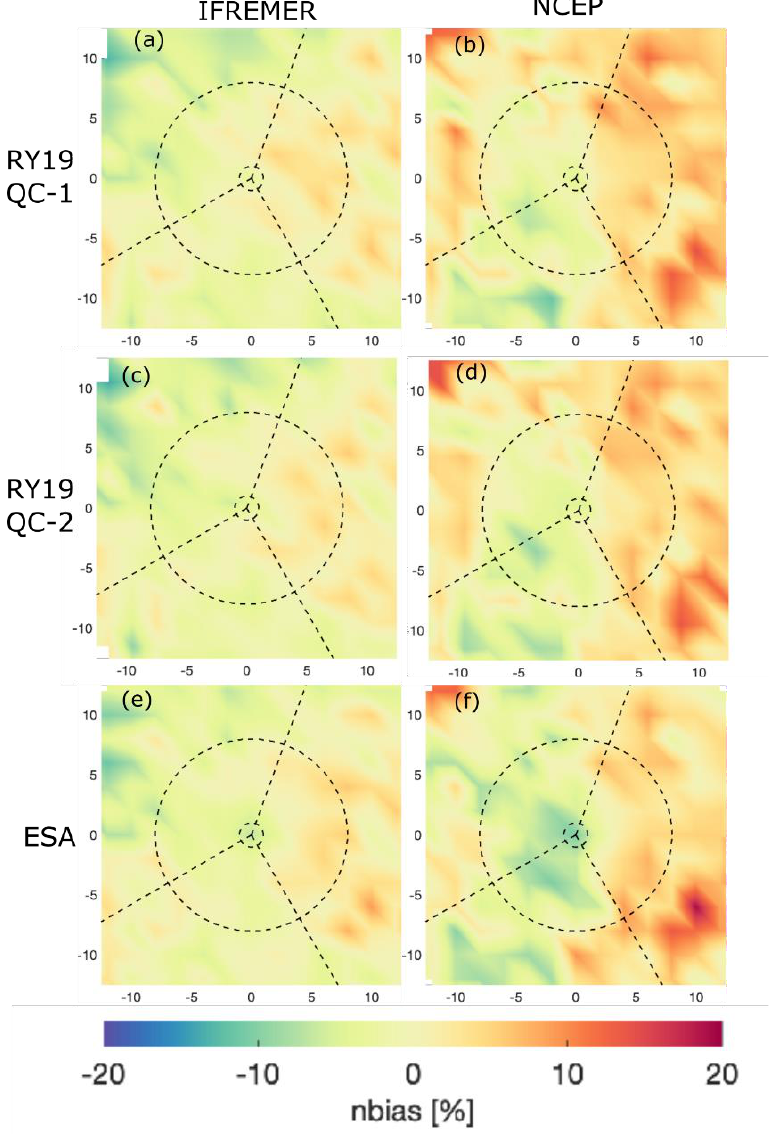
Figure A1. Normalized bias in a TC-centered frame of reference. Left column from Ifremer hindcast. Right column from NCEP hindcast. Top to bottom is RY19 QC-1, RY19 QC-2, and ESA altimeter data.